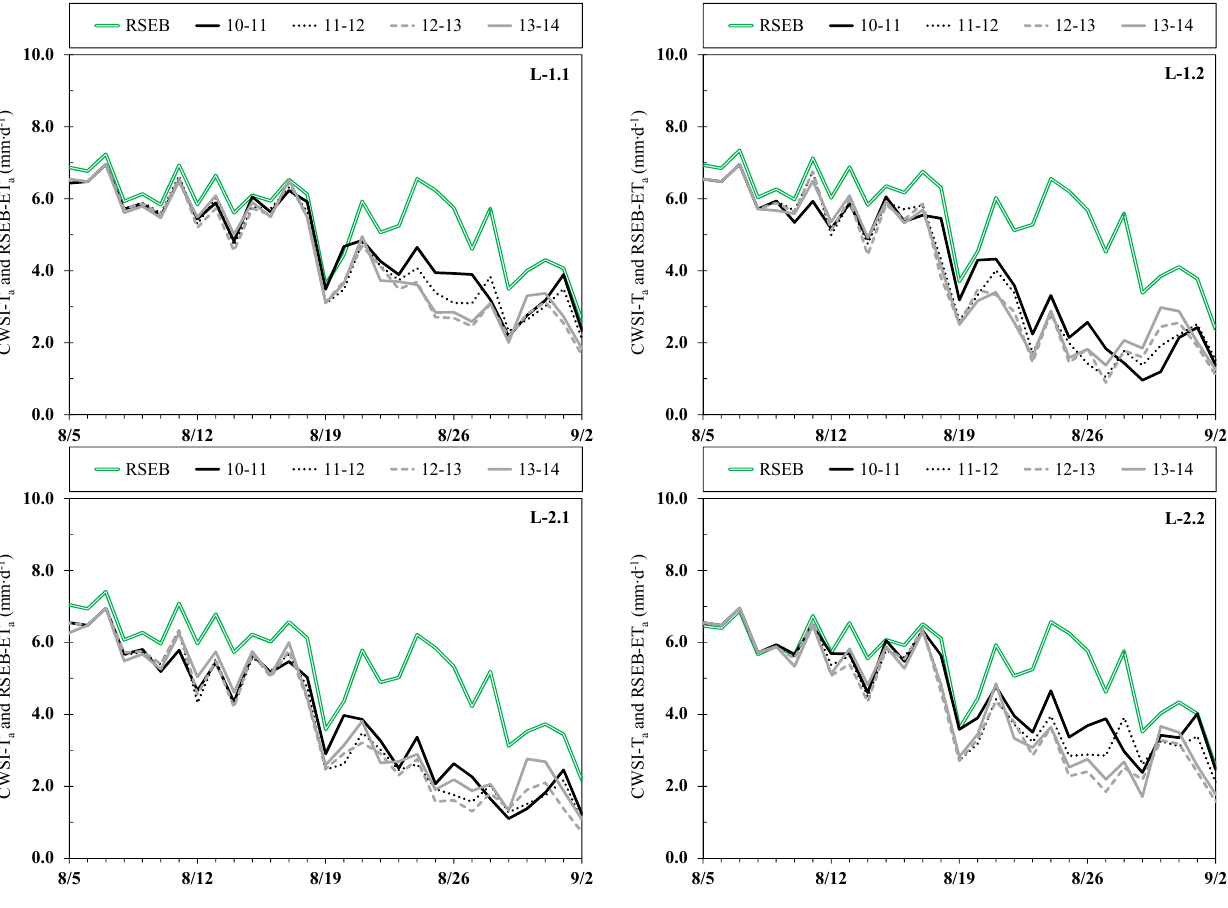
Table 4. Mean (in mm·d − 1 ) and total (in mm) maize water use during the study period (29 d). CWSI-T a RSEB-ET Plot